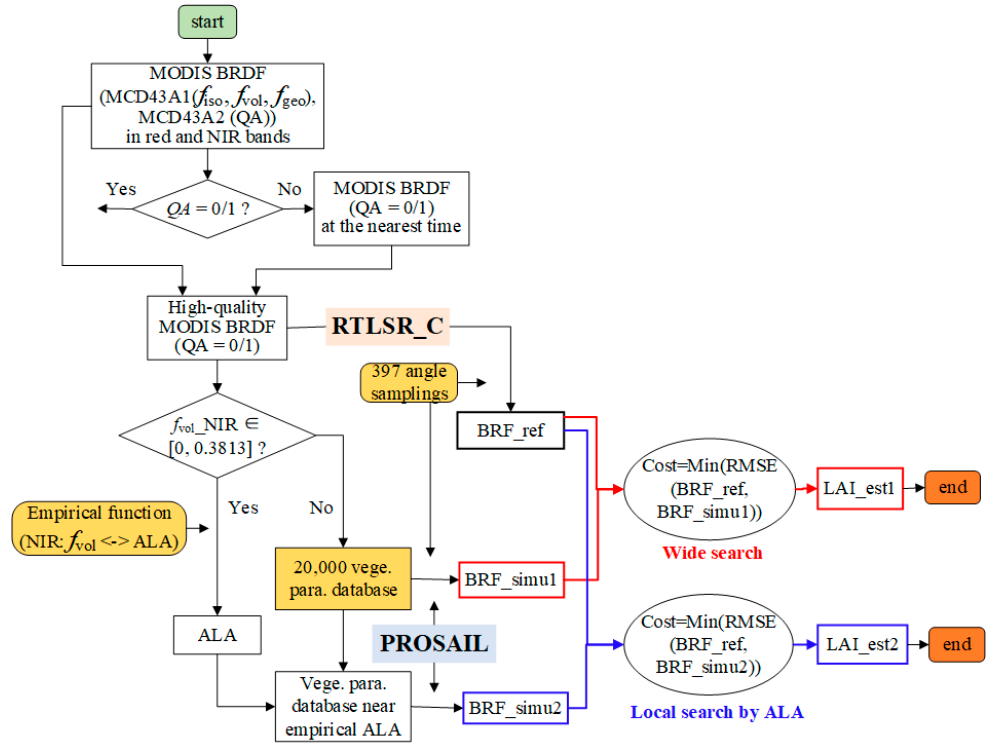
Figure 8. Application process of the proposed method in this study for LAI estimation with the MODIS BRDF parameter product.